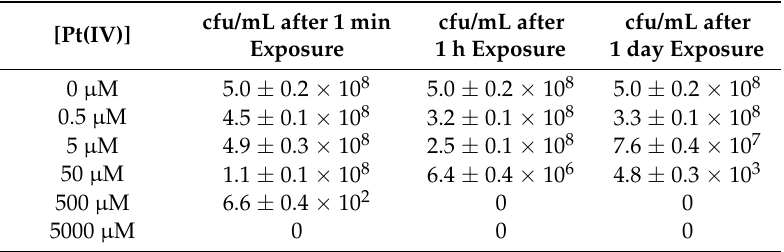
Table 2. Toxicity study where C. metallidurans was reacted with aqueous